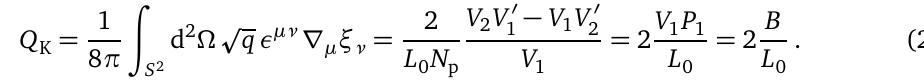
= V = 0, while the BH horizon is at V 1 2 = 0